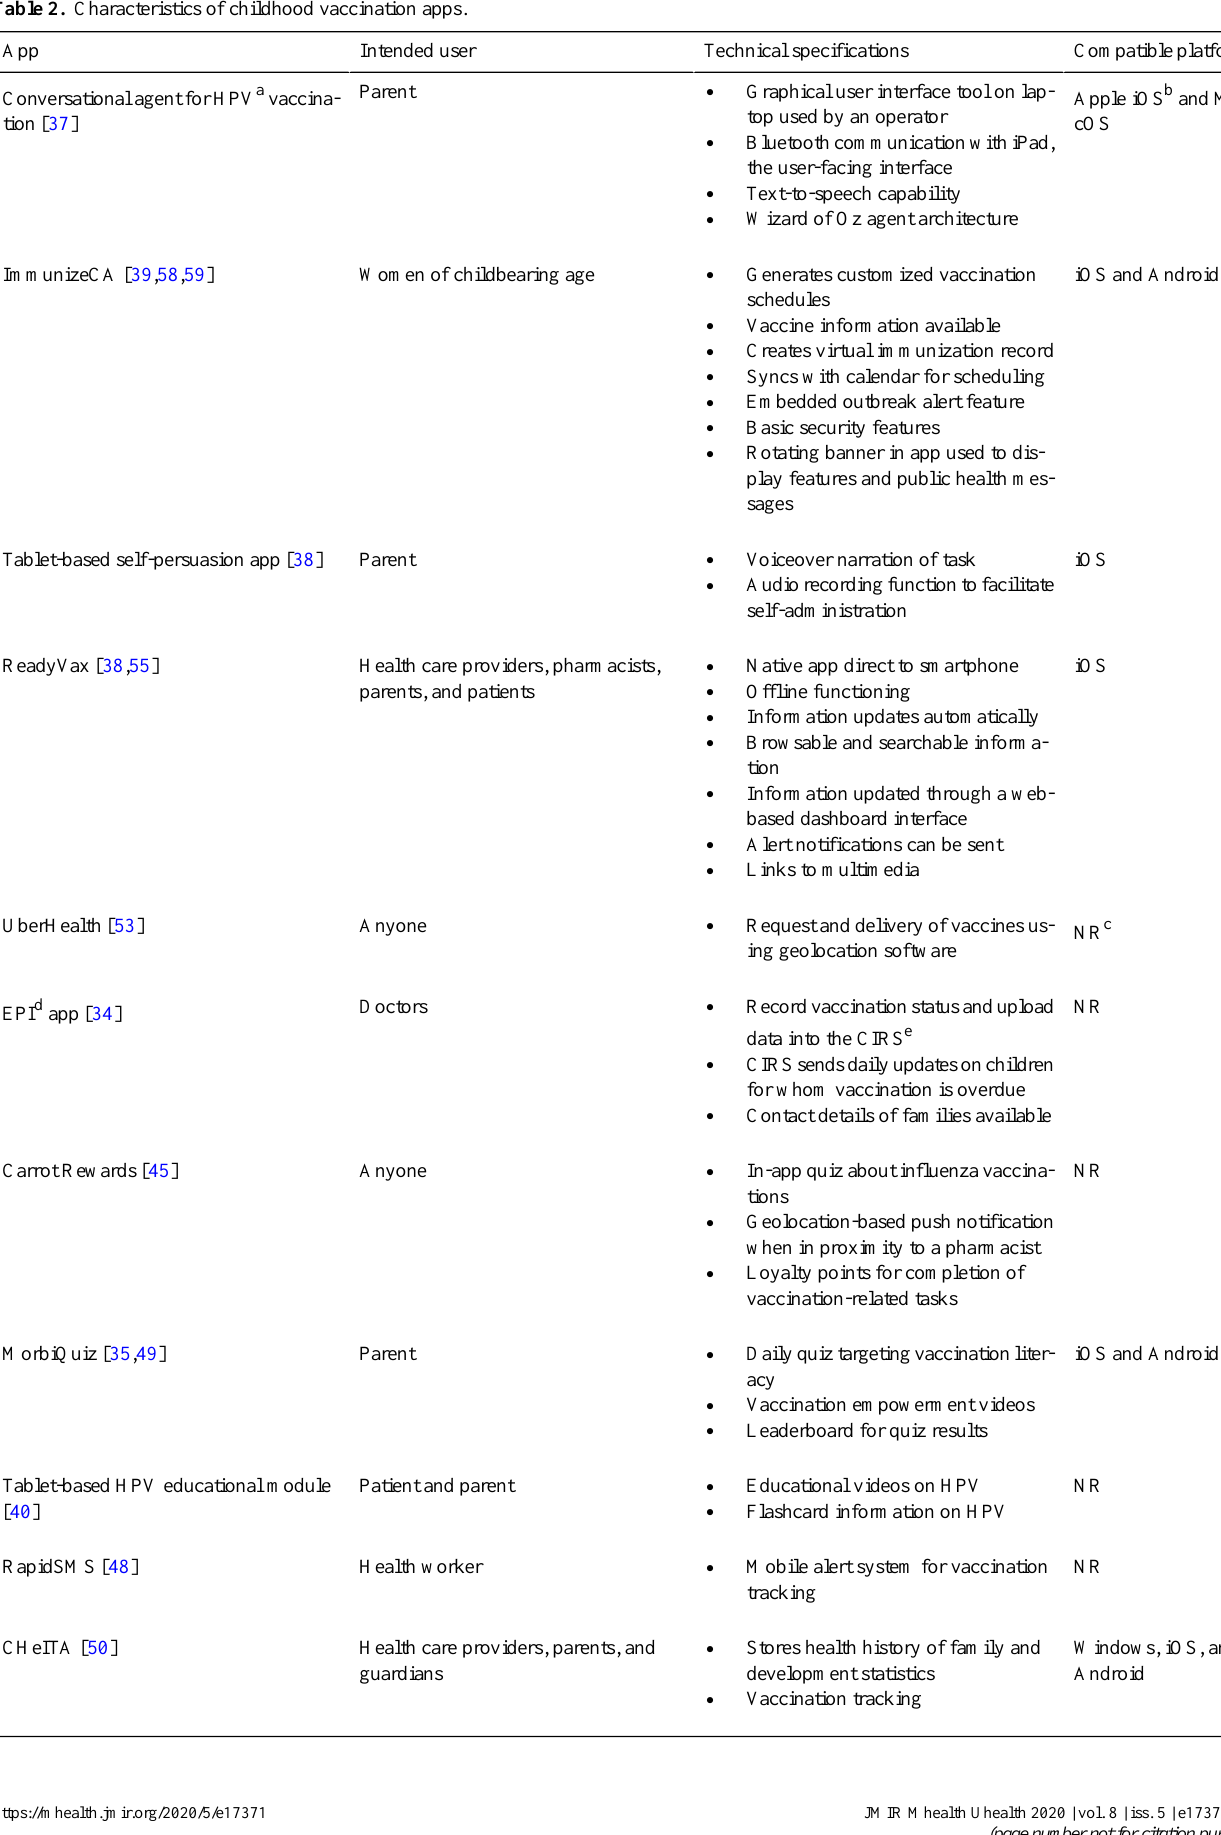
Table 2. Characteristics of childhood vaccination